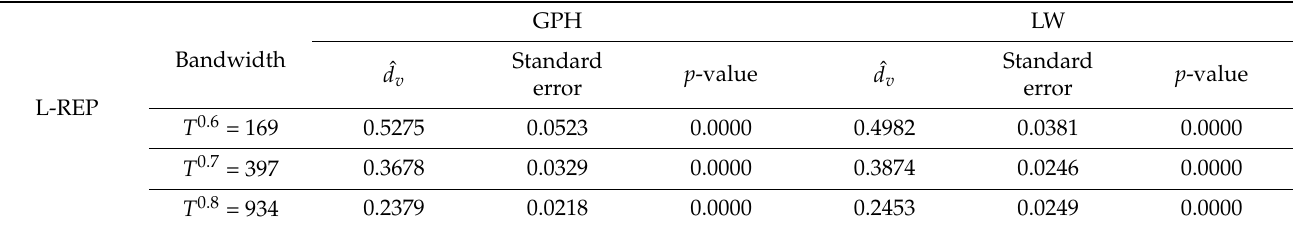
Table 4. Results of GPH and LW tests in the conditional variance.